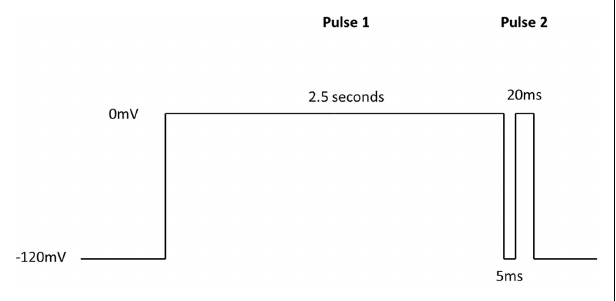
FIGURE 4 | IonWorks Quattro Nav pulse protocol designed specifically to characterize interaction with the inactivated-state of the channel. Pulse 1 drives Nav channels primarily into the inactivated state, the 5ms step back to − 120mV relieves the fast inactivation, and the second depolarizing pulse (Pulse 2) defines a compound’s ability to bind to the inactivated-state of the channel.